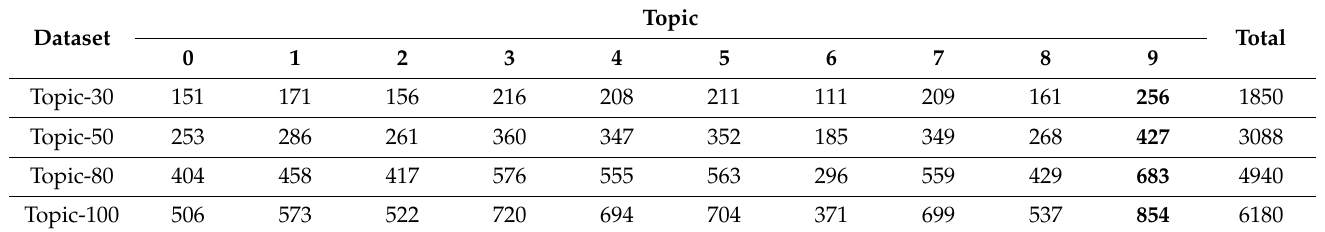
Table 5. Topics Distribution in Datasets (Bold text is highest number of topic group for each dataset).